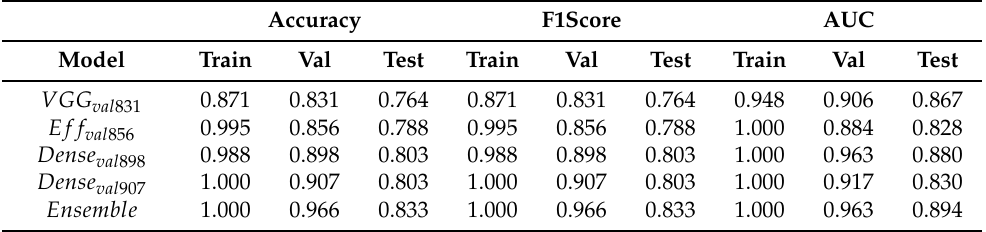
Table 1. Performance metrics of the selected ensemble as well as of each of its 4 individual